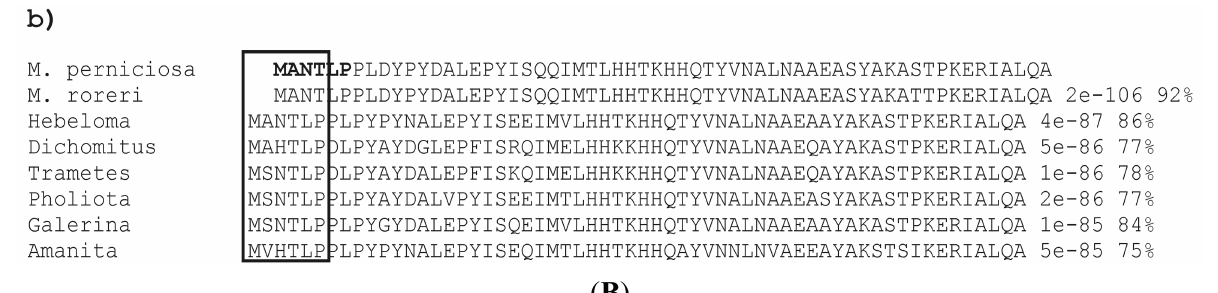
Figure 1. ( A ) Alignment of the Mp SOD2 deduced amino acid sequence with MnSOD2 polypeptides from other organisms; Conserved residues are boxed in black frame.